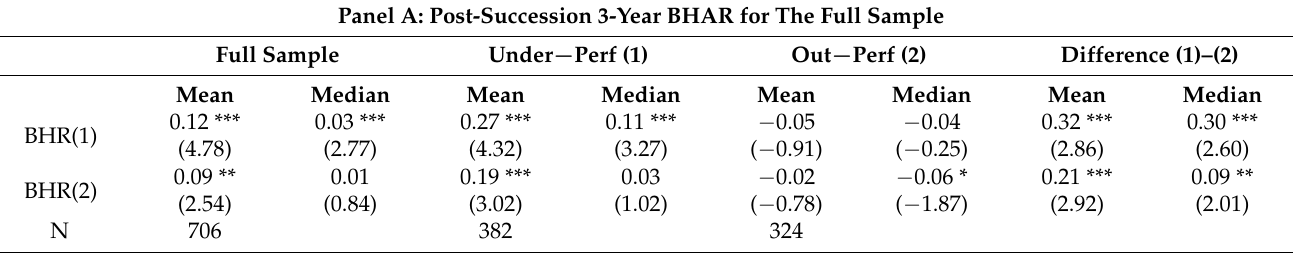
Table 6. Postevent three-year BHAR for under- and outperforming CEOs. Panel A: Post-Succession 3-Year BHAR for The Full Sample Full Sample Under − Perf (1)